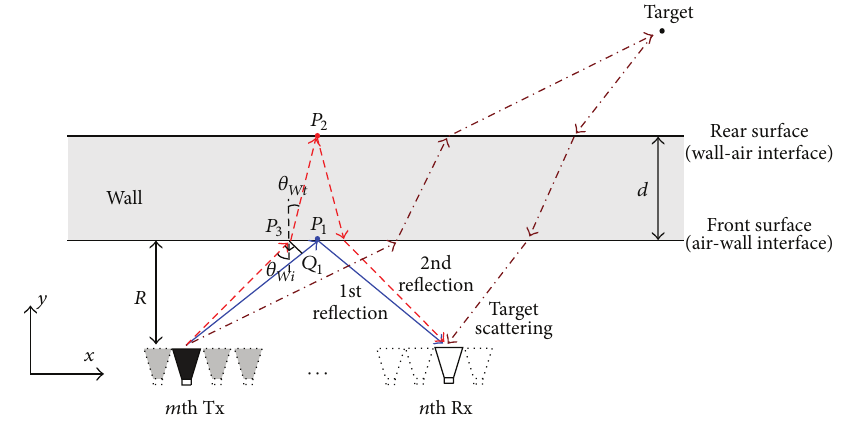
Figure 1: Imaging geometry of TWR with MIMO array.